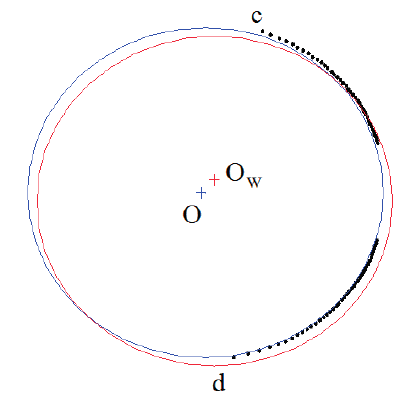
Figure 8. Fitting circle by limited data.